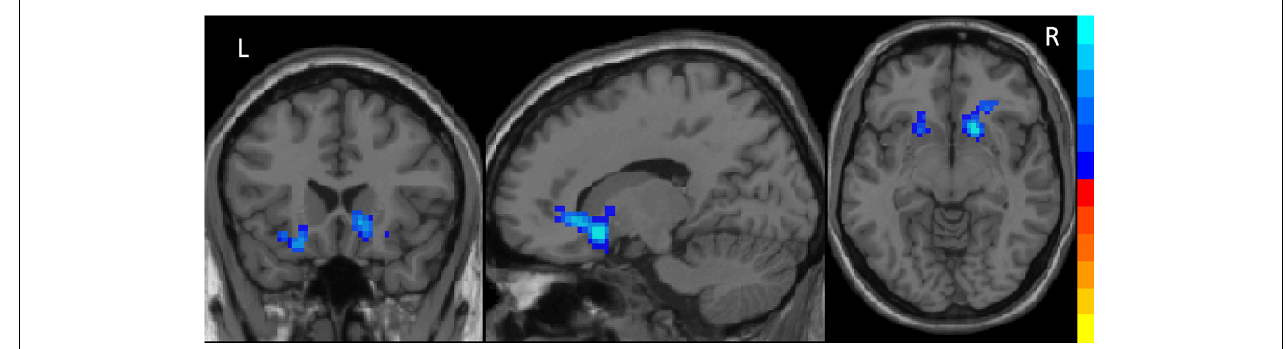
FIGURE 1 | Decreased ReHo values in striatum including the right caudate, left pallidum and bilateral putamen in iRBD patients. The results were corrected by GRF (significant level is set at P < 0.05 at cluster and P < 0.01 at voxel level).